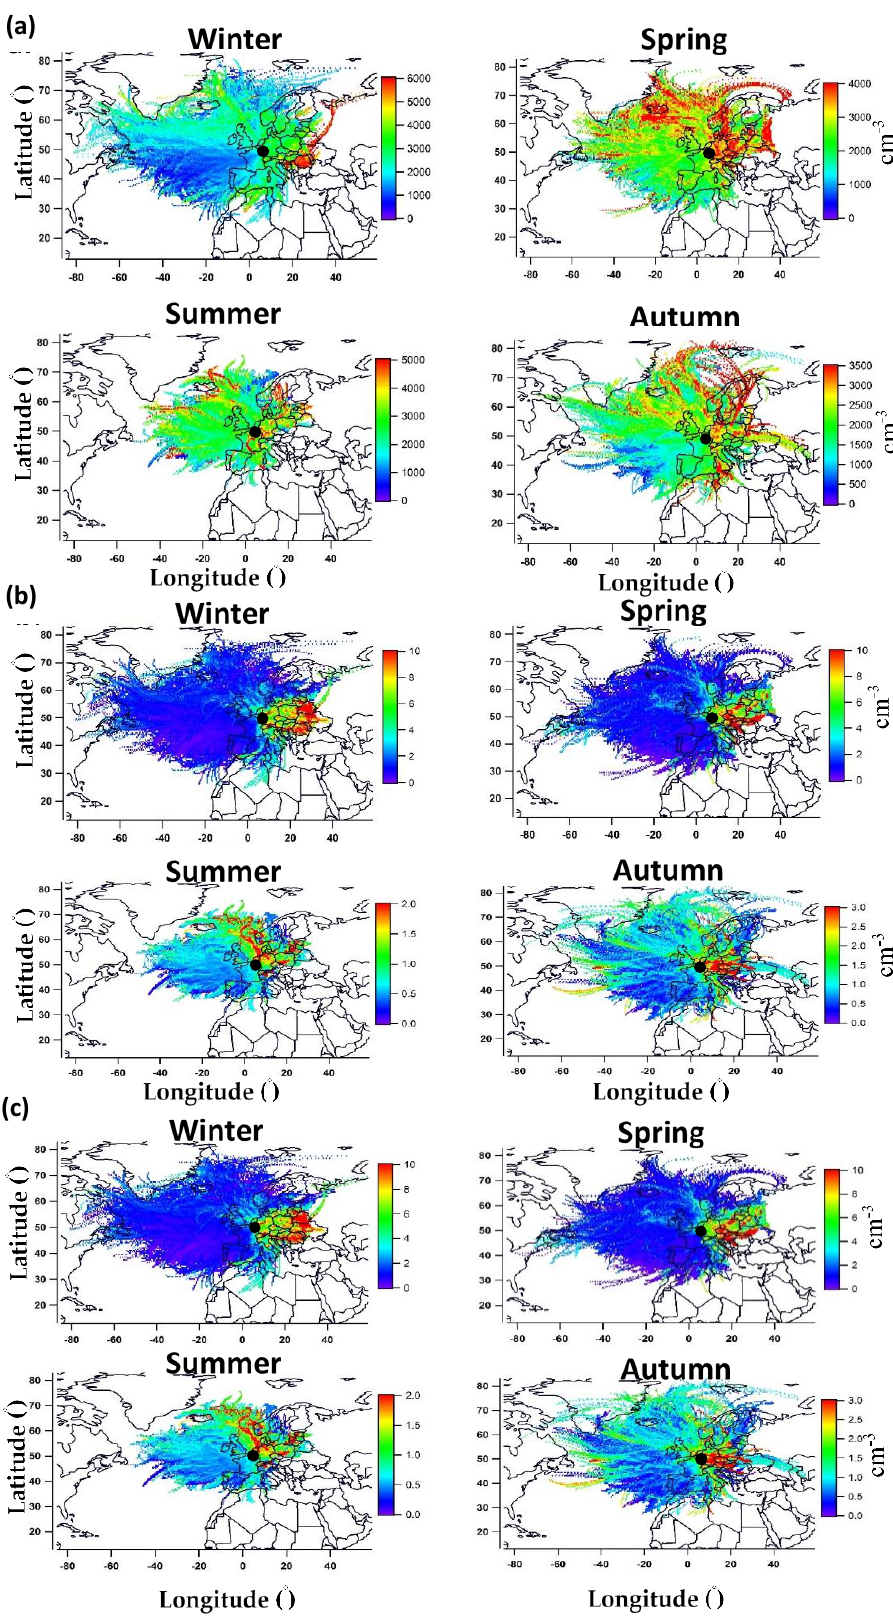
Figure 10. PSCF results for: ( a ) N 10–550 , ( b ) N 0.54–1.15 , and ( c ) N 1.15–4.5 , for the four seasons over the 2012–2018 period measured at the OPE station (black dot).